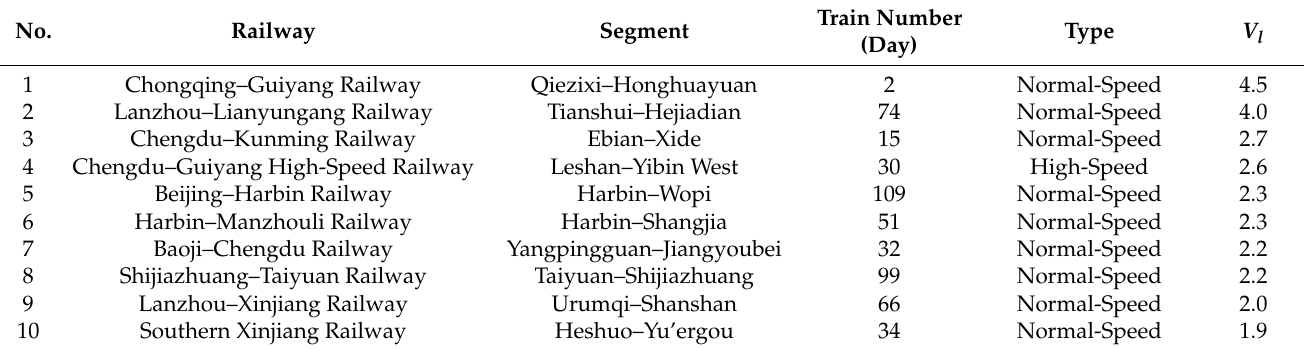
Table 4. The Most Vulnerable Sections in the Railway Lines.